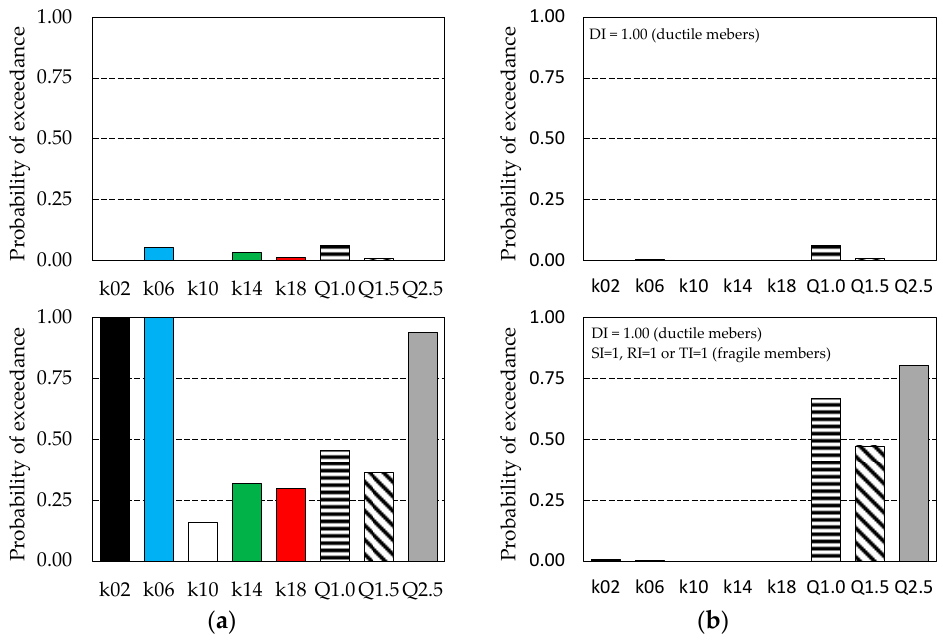
Figure 6. Probability of exceedance of the NC limit state for a g = 0.189 g: ( a ) 4-storey structures; ( b ) 8-storey structures.